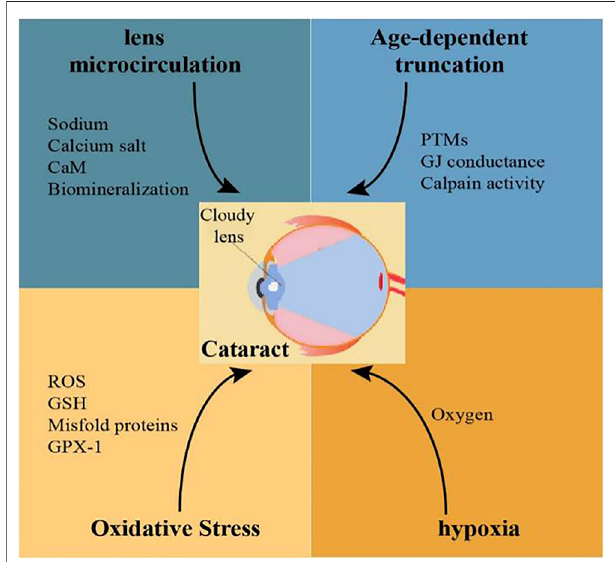
FIGURE 2 | Possible mechanisms related to Cx46 and Cx50 mutations involved in the pathogenesis of